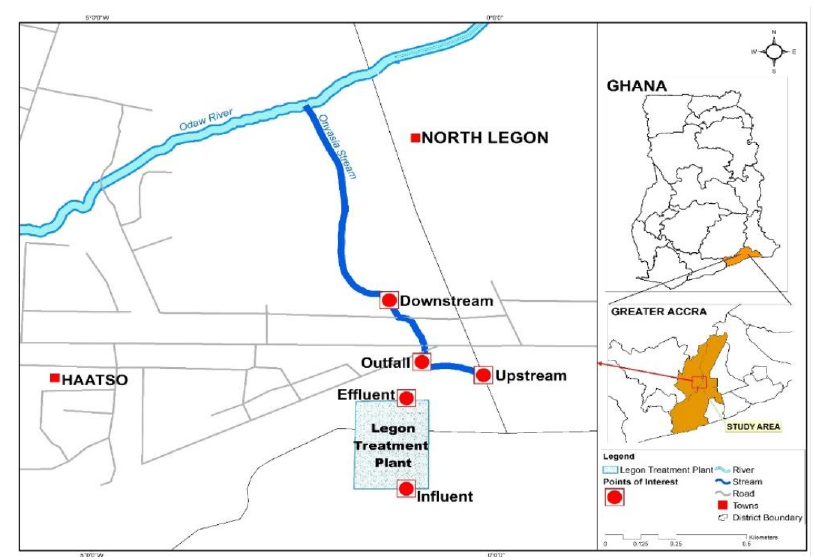
Figure 2. Wastewater and Onyasia stream water sampling sites with reference to the Legon Sewage Treatment plant, Accra,